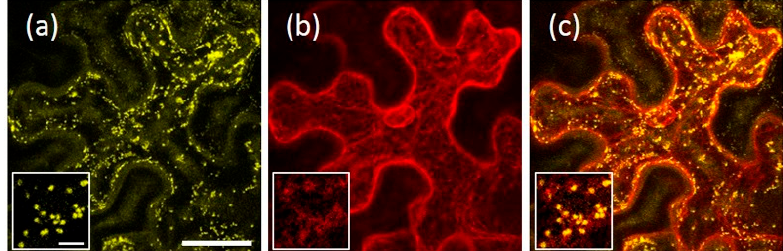
Figure 9. AtRMRs oligomerization. AtRMR trimer or tetramer formation tested by combined experiments of BiFC and co-expression in Nicotiana benthamiana leaves. Stacked confocal images, excepted inserts ( a – c , single images), of epidermal cells expressing AtRMR2 Δ RingSer-nYFP, AtRMR2 Δ RingSer-cYFP and AtRMR1 Δ Ring-RFP. ( a ) YFP signal; ( b ) RFP signal; and ( c ) merged images. Scale bars = 30 µm; and 5 µm (inserts).